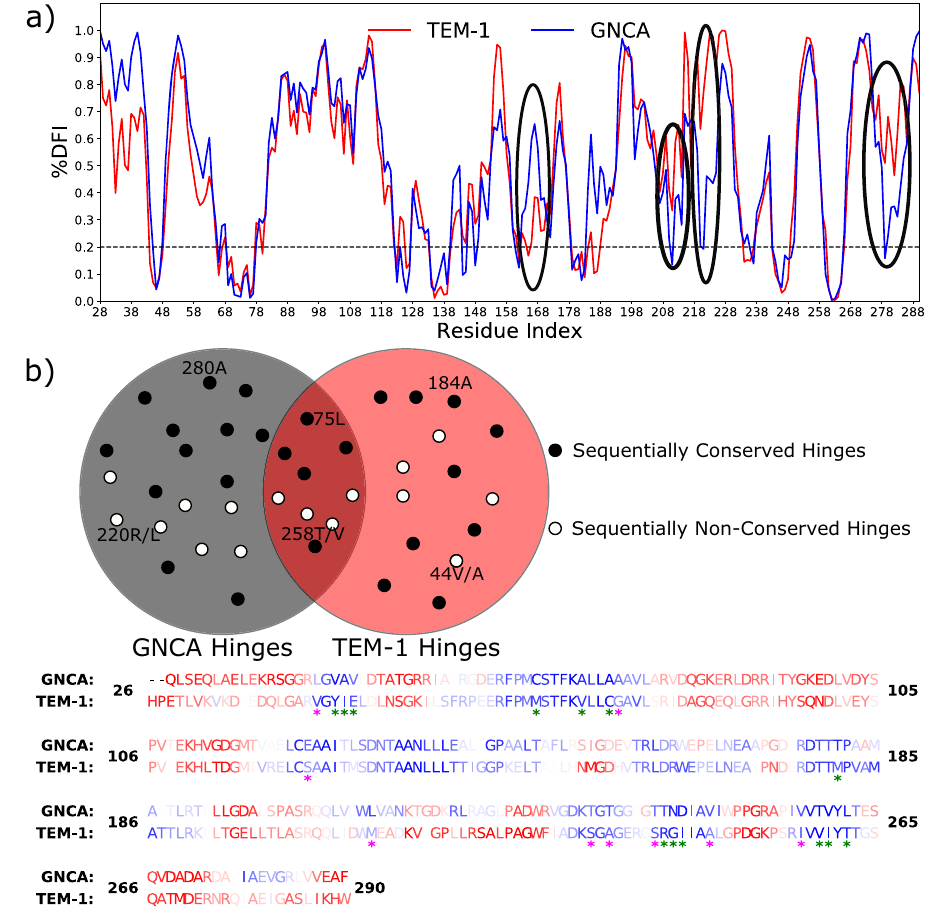
Fig. 1 Differences in the fl exibility pro fi les of GNCA and TEM-1 β -lactamases. a Comparison of the fl exibility pro fi le of ancestral β -lactamase (GNCA, blue) with the modern β -lactamase (TEM-1, red). We identify several regions focused around residues 166, 205, 223, and 280, where key differences (highlighted, black circles) in the dynamics of GNCA and TEM-1 β -lactamases, are observed. Typically, residues with the percentile rank of their DFI score (%DFI) <0.2 are deemed rigid hinges. These residues have been observed to play a critical role in the functional dynamics of the protein 28,55 – 58 . b A Venn diagram illustrating the amino acid conservation of select common and non-common hinges in GNCA and TEM-1 β -lactamase. The circles schematically (only a subset of hinges are graphed) represent residues in GNCA and TEM-1 β -lactamase with or without amino acid substitutions. The alignment of TEM- 1 and GNCA β -lactamase amino acid sequences are color-coded based on their DFI scores. Blue is rigid and red is fl exible, with a spectrum of blue – white – red based on their DFI values. We observe several residue positions with conserved rigidity through evolution (common hinges, 41 in total) in addition to shifts in hinges (non-common hinges, 10 in GNCA and 11 in TEM-1 β -lactamase). Many of these residue positions have conserved amino acid identity (sequentially conserved), while others have evolved into a different amino acid (hence, sequentially non-conserved). For example, residue 220 is arginine, which is a hinge position in GNCA, but has evolved to leucine in TEM-1 β -lactamase while losing its rigidity (shown as 220 R/L). The residue positions that have maintained their rigidity without conserving their amino acid identity are highlighted in the sequence alignment by a green asterisk. The residues where fl exibility increased or decreased beyond 0.2 (non-common hinges) along with a substitution are highlighted with a pink asterisk. The computed data is provided as a Source Data fi